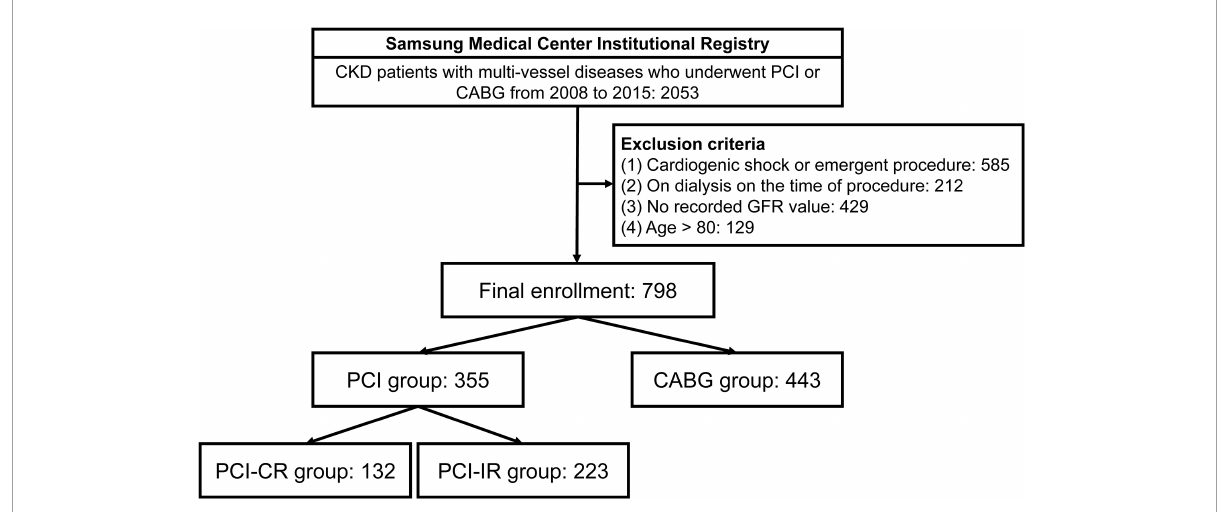
FIGURE1 Study flow. CKD, chronic kidney disease; PCI, percutaneous coronary intervention; CABG, coronary artery bypass graft; GFR, glomerular filtration rate; PCI-CR, percutaneous coronary intervention with complete revascularization; PCI-IR, percutaneous coronary intervention with incomplete